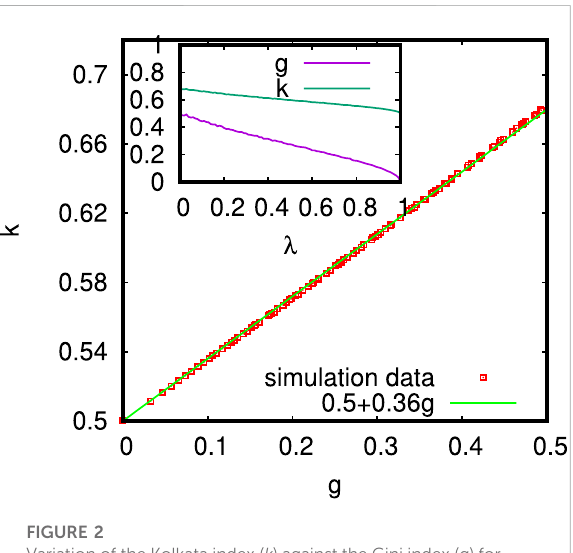
FIGURE 1 Lorenz curve L ( f ) (shown in red) and complementary Lorenz curve L c ( f )(showningreen)usedtocalculatetheinequalityindices Gini ( g = 2 S , S denoting the area of theshaded region between the equality line and the Lorenz curve) and Kolkata (given by the ≡ 1 − L ( k )). Here, L represents the cumulative fi xed point k = L c ( k ) fraction of wealth possessed by p fraction of the people, when ordered from poorest to the richest. For the physical systems considered here, such as the kinetic exchange model of gas, the wealth could be replaced by the kinetic energy and the fraction of people by the fraction of particles. For model systems such as percolation, sandpiles, or the fi ber bundles, the horizontal axis represents the fraction ( f ) of clusters or avalanches when all avalanches are arranged from the lowest to the highest size. The vertical axis ( L ) represents the fraction of the cumulative mass of these clusters or avalanches.